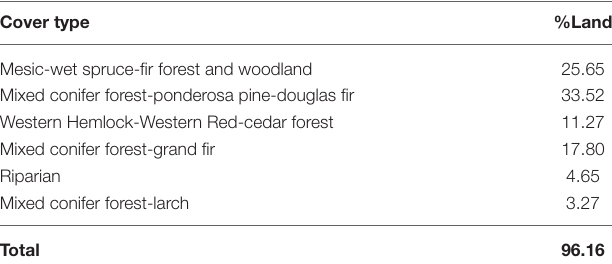
TABLE 1 | Percentage of the Prospect Creek Basin case study landscape in each of the major cover types. Cover